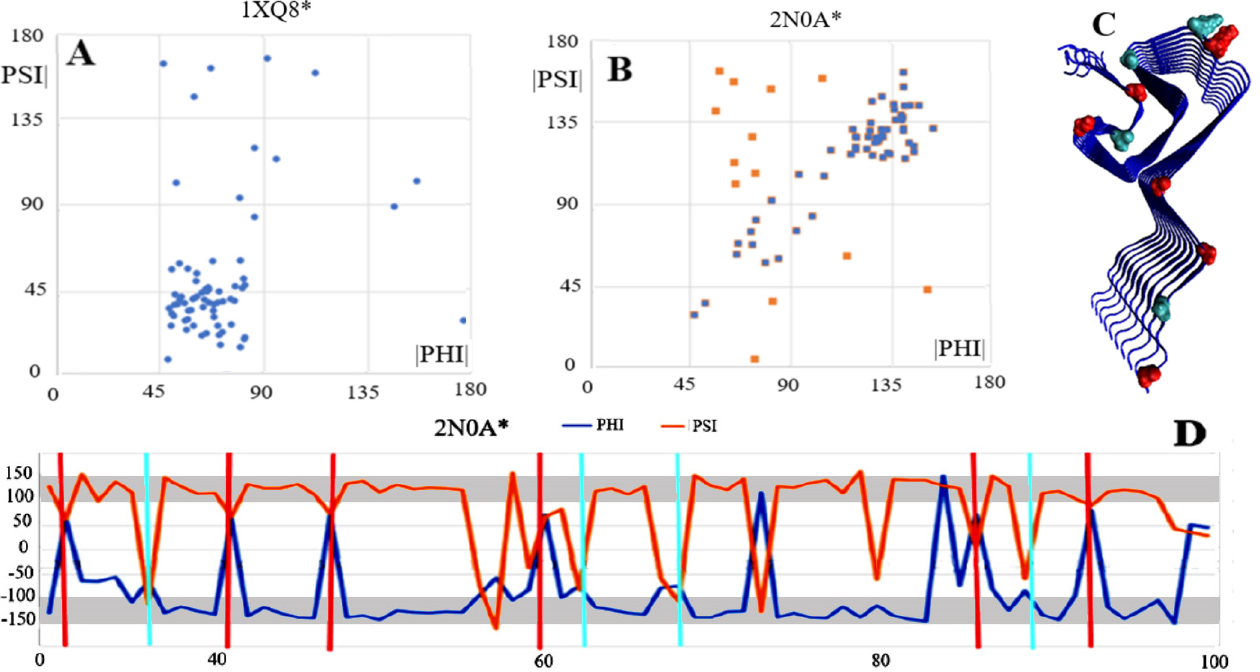
Figure 11. Characteristics of aSyn in the form of: ( A )—distribution of angles |Phi| and |Psi| in native form (1XQ8*); ( B )—distribution of angles |Phi| and |Psi| in amyloid form (2N0A*); ( C )—3D form of amyloid with highlighted residues: cyan—R α conformation, red—helical L α conformation, as these positions were highlighted in the profiles in D. ( D )—set of Phi and Psi profiles for 2N0A* with highlighted positions L α —red and R α helical—cyan.